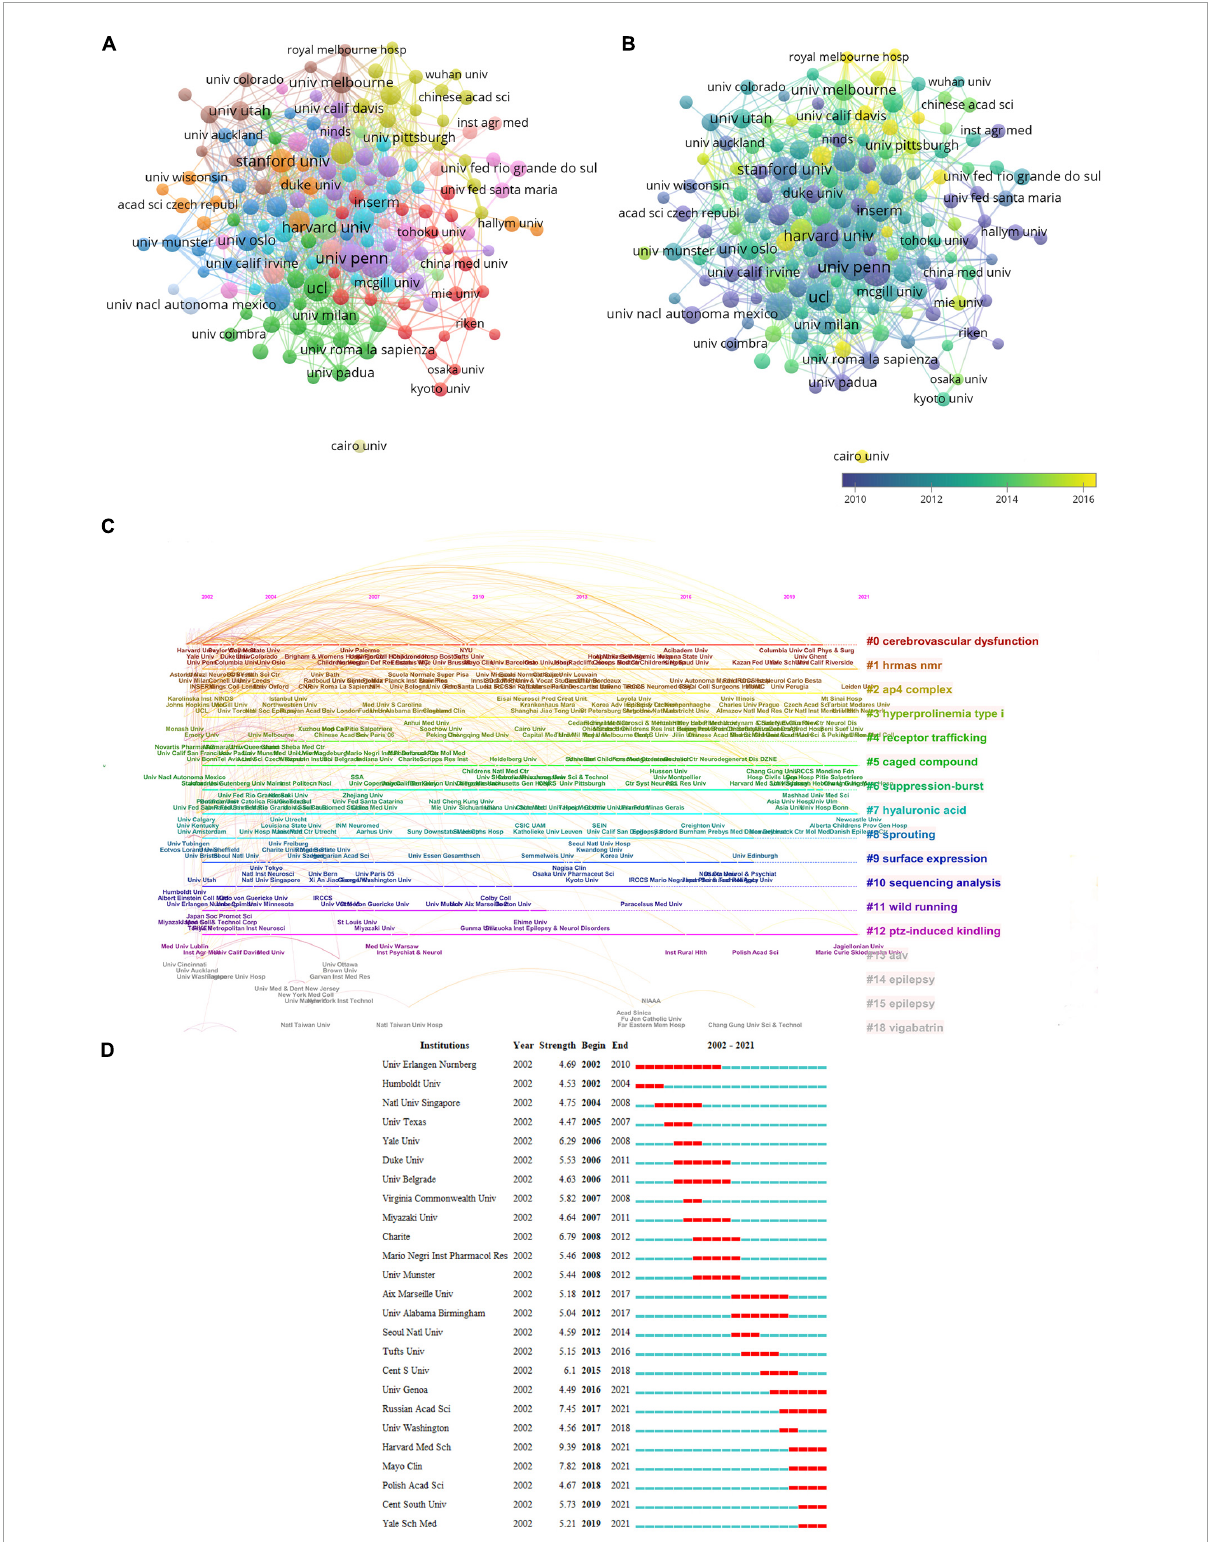
FIGURE4 Visualization of institutes. (A) Co-occurrence of institutes. (B) Visualization of countries based on APY. (C) Timeline distribution of the top 19 clusters. (D) Top 25 institutes with strongest burstness.